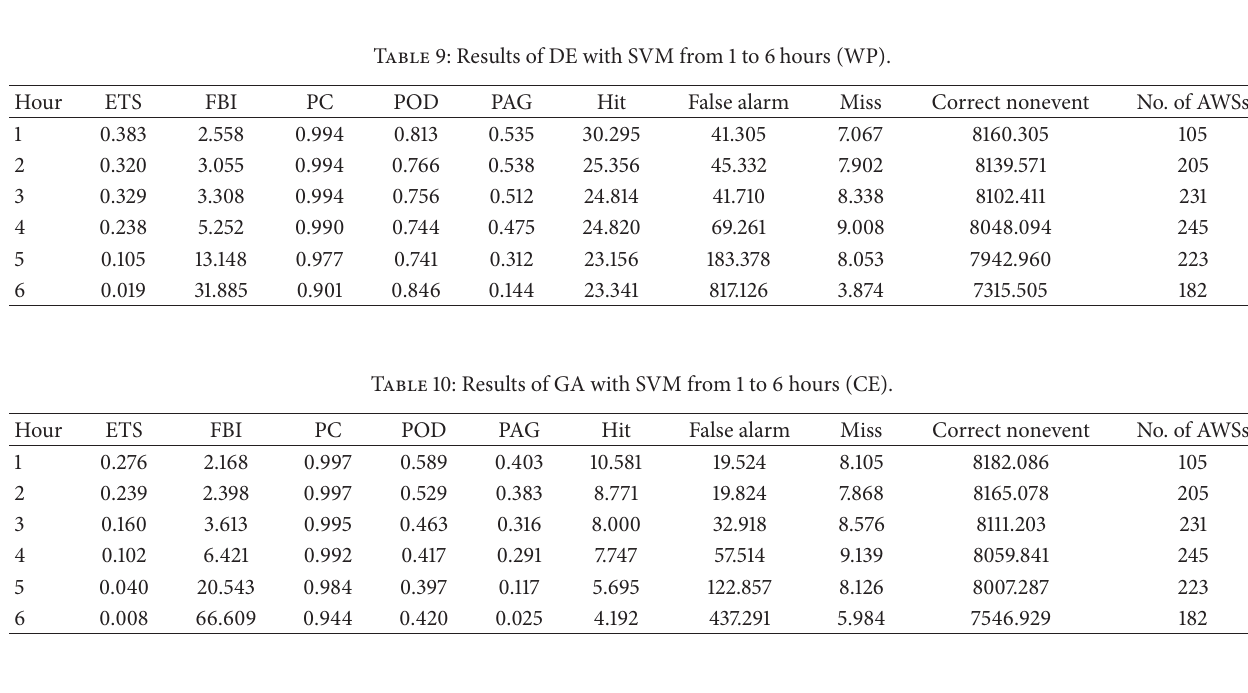
Table 11: Results of GA with SVM from 1 to 6hours